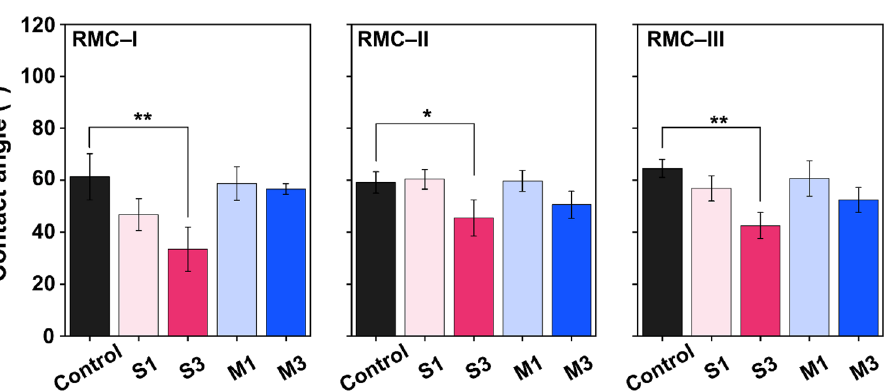
Figure 5. Surface wettability performance. A varying number of asterisks indicate significant differences by post-hoc Tukey’s test (** P < 0.01, *** P <